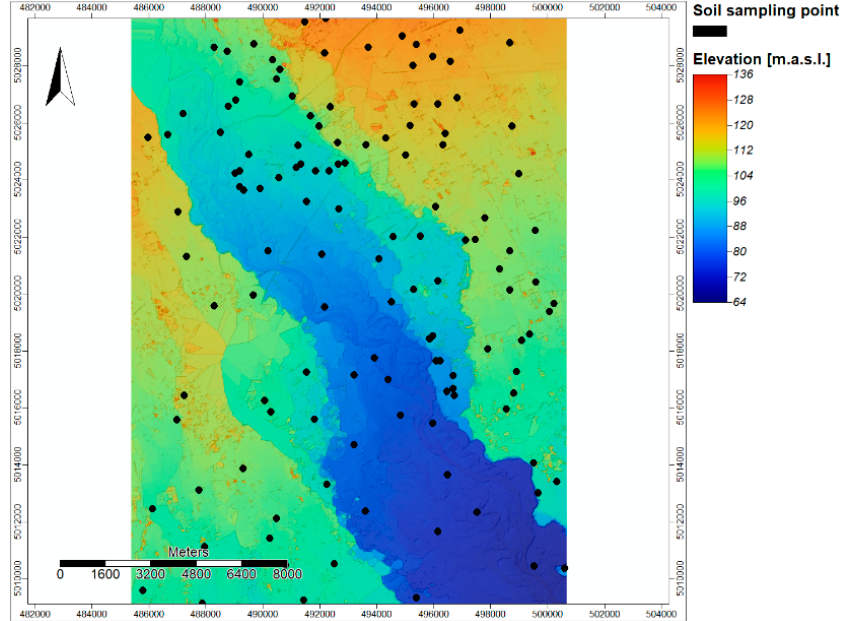
Figure 2. Hybrid digital elevation model with 10 m resolution based on TanDEM-X (12 m resolution) and Lidar (1 m) digital terrain models. Color-coded elevation with hill shading. Black dots show the location of the sampled soil profiles.